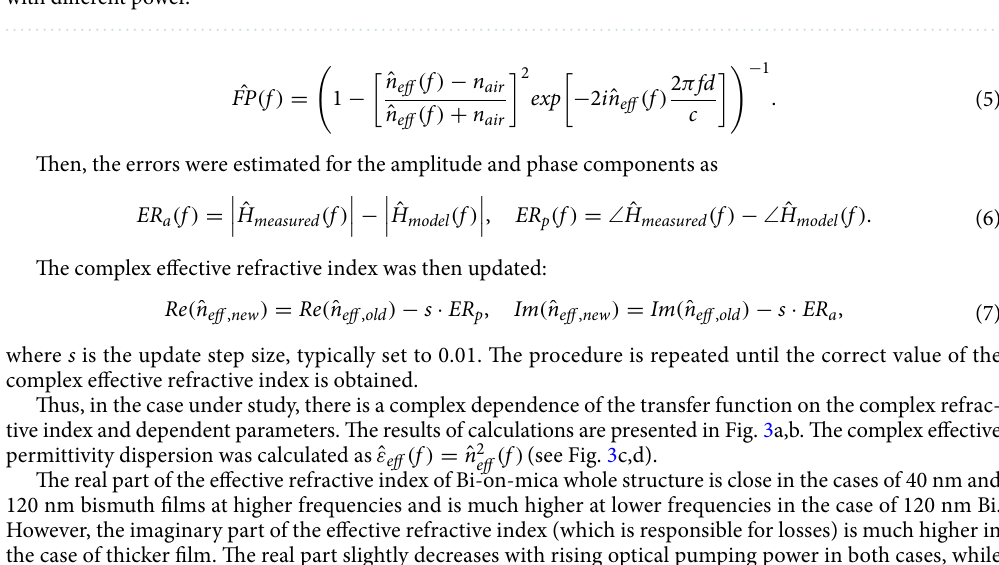
Figure 3. Results of experiment. Complex effective refractive index ( a,b ) and permittivity ( c,d ) dispersions of Bi-on-mica structures (with Bi thickness of 40 ( a,c ) and 120 ( b,d ) nm) which are influenced by optical pumping with different